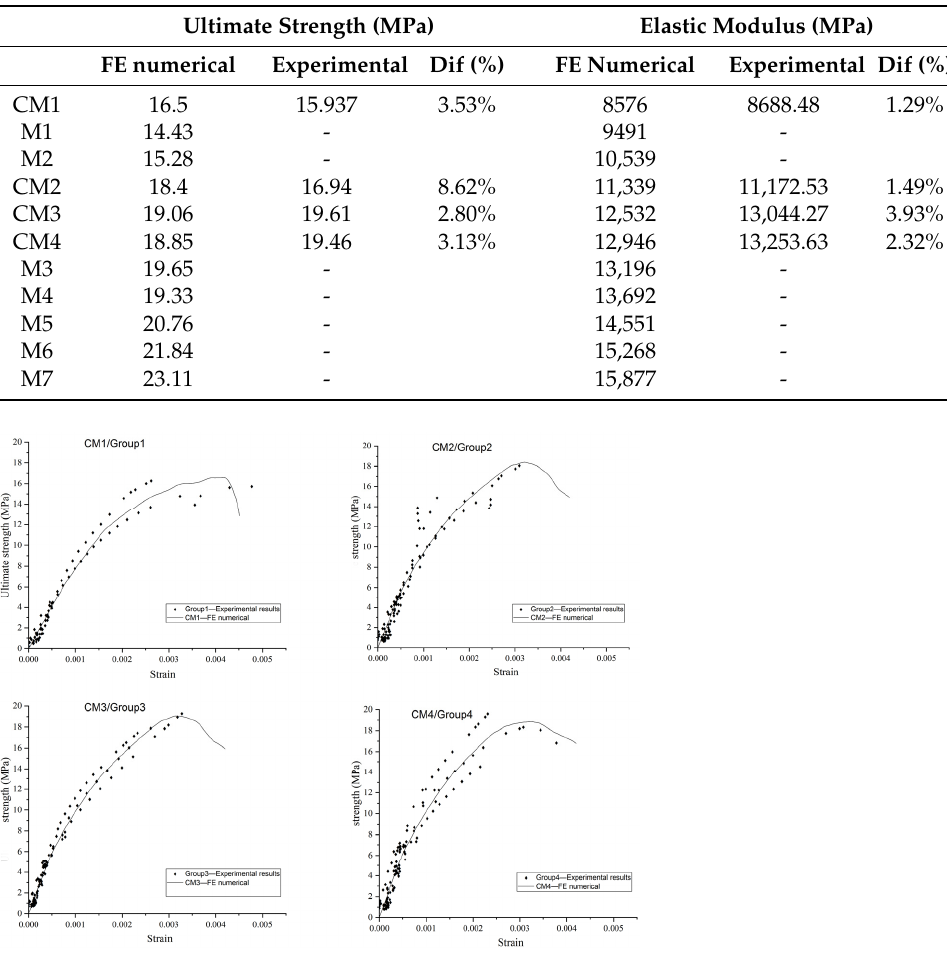
Figure 11. Comparison of the stress-strain curve between the simulated results and the experimental result.